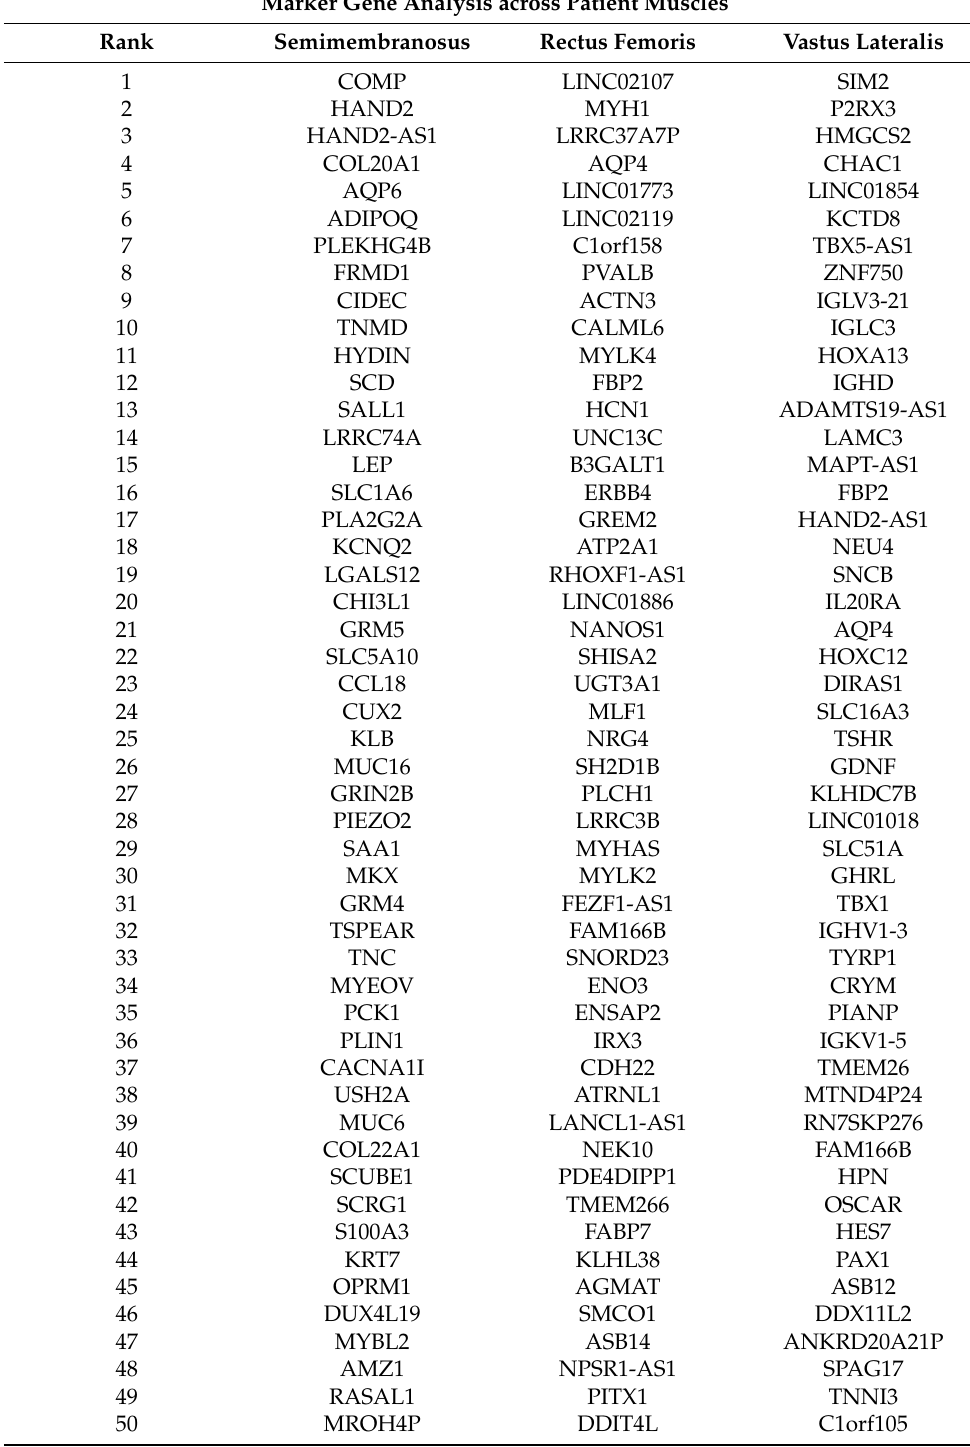
Table 3. Top 50 of most differentially expressed genes across LGMD-R12 patient